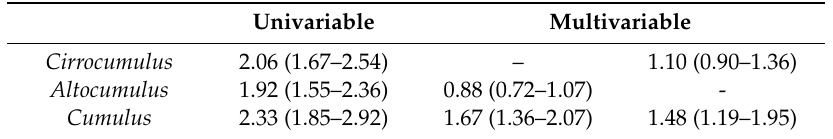
Table 3. Odds ratio per unadjusted standard deviation (OPERA 1 ) for percent mammographic density measures in predicting interval breast cancer (Nguyen et al. (2018)) [13].